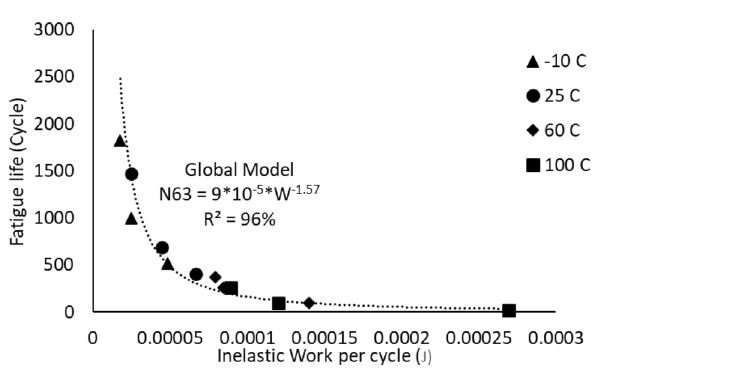
Figure 14. The Morrow energy global model.